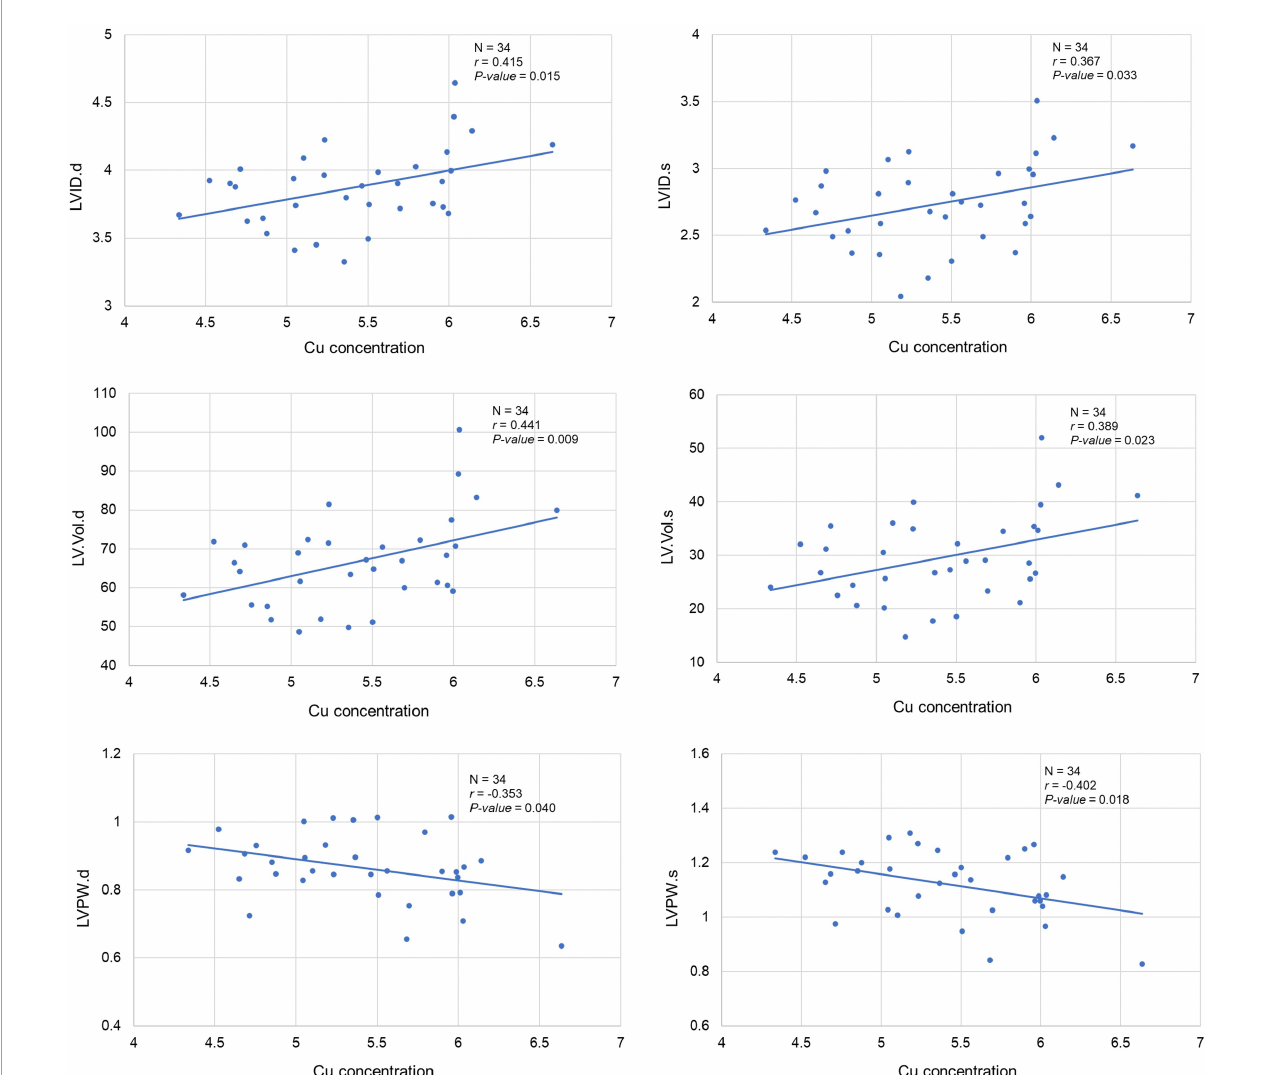
FIGURE3 Correlation between cardiac copper (Cu) concentration and echo phenotypes (LVID, LV.Vol, and LVPW). The x-axis indicates the Cu concentration ( µ g/g), and y axis denotes various echocardiography parameters. The Pearson correlation coefficient was used to determine the relationship between cardiac Cu concentration and echo phenotypes. The Pearson correlation r and P -values are indicated in the plots. LV, left ventricular; s, end-systole; d, end-diastole; LVID, LV internal diameter; LV.Vol, LV volume; LVPW, LV posterior